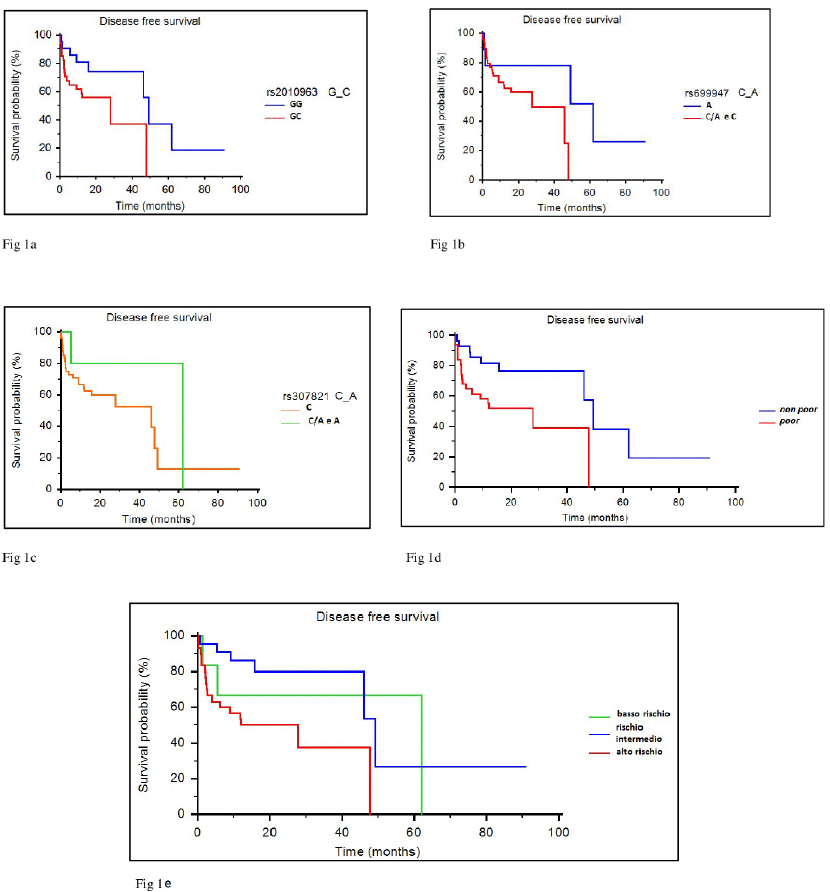
Fig 1. Progression free survival (PFS, expressed in months) according to selected VEGF-A,VEGFR-2 and VEGFR-3 polymorphisms. a) VEGF-A polymorphisms. b) VEGFR-2 polymorphisms. c) VEGFR-3 polymorphisms. d) Poor group (patients presenting all 3 polymorphisms) vs not poor group (patients presenting 1 or 2 polymorphisms). e) High-risk group (patients presenting all 3 polymorphisms) vs intermediate-risk group (patients presenting 2 polymorphisms) vs low- risk group (patients presenting at most 1